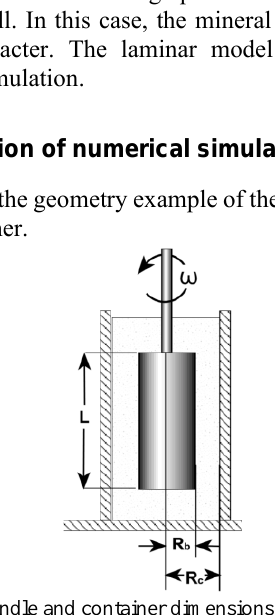
Fig. 8. Comparison of the numerically simulated spindle torque T depending on the temperature t O with the experiment.